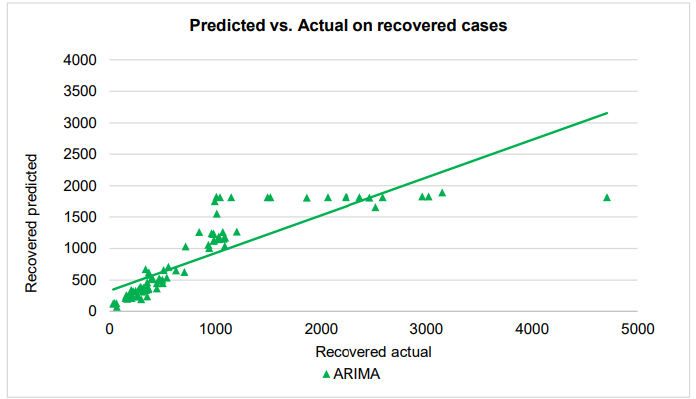
Figure 9. A scatter plot of the recovered cases by ARIMA on the testing dataset.